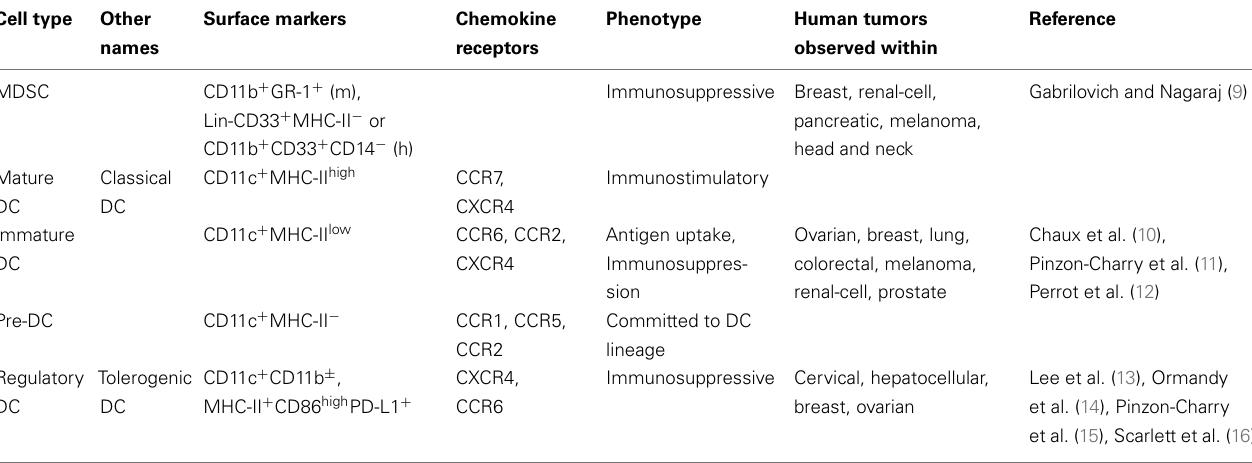
Table 1 | Phenotypic features of different tumor-infiltrating myeloid cell